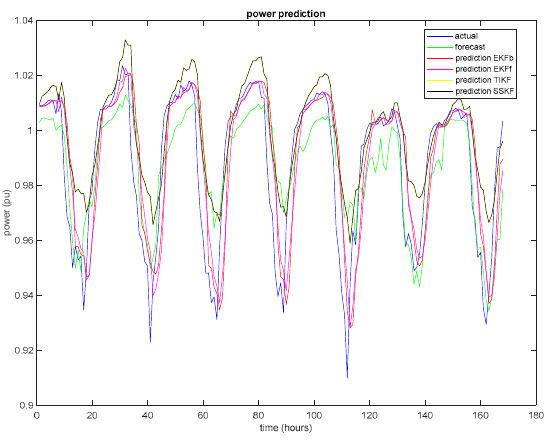
Figure 9. Power generation prediction with KF.